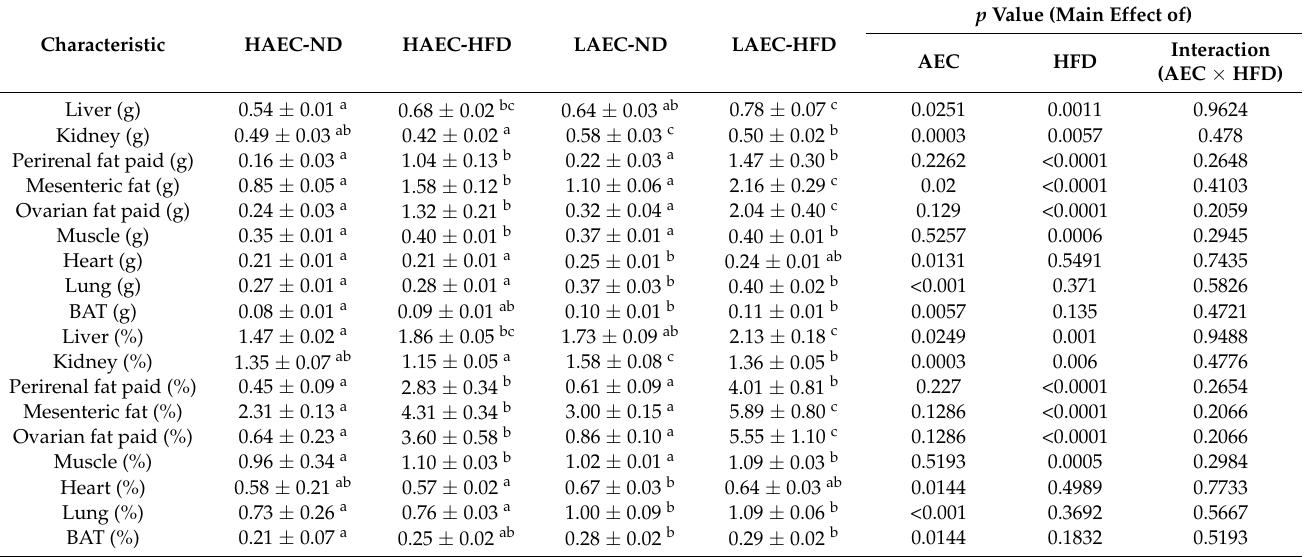
Table 2. Intrinsic aerobic exercise capacity in HFD intake on body